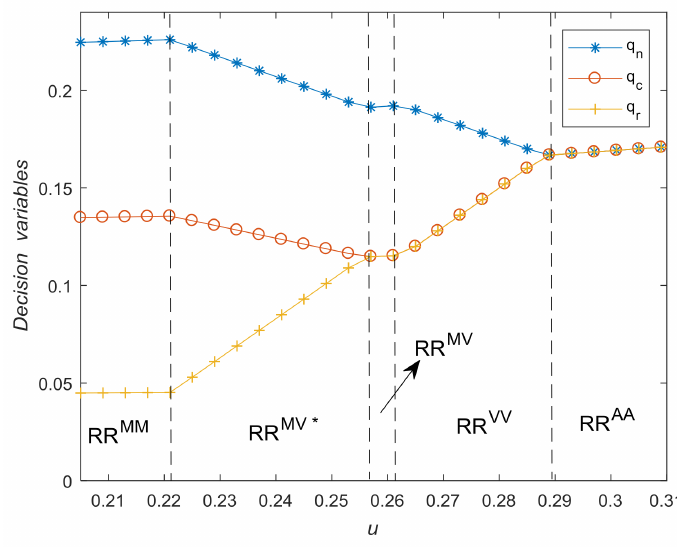
Figure 4. The impact of u on optimal